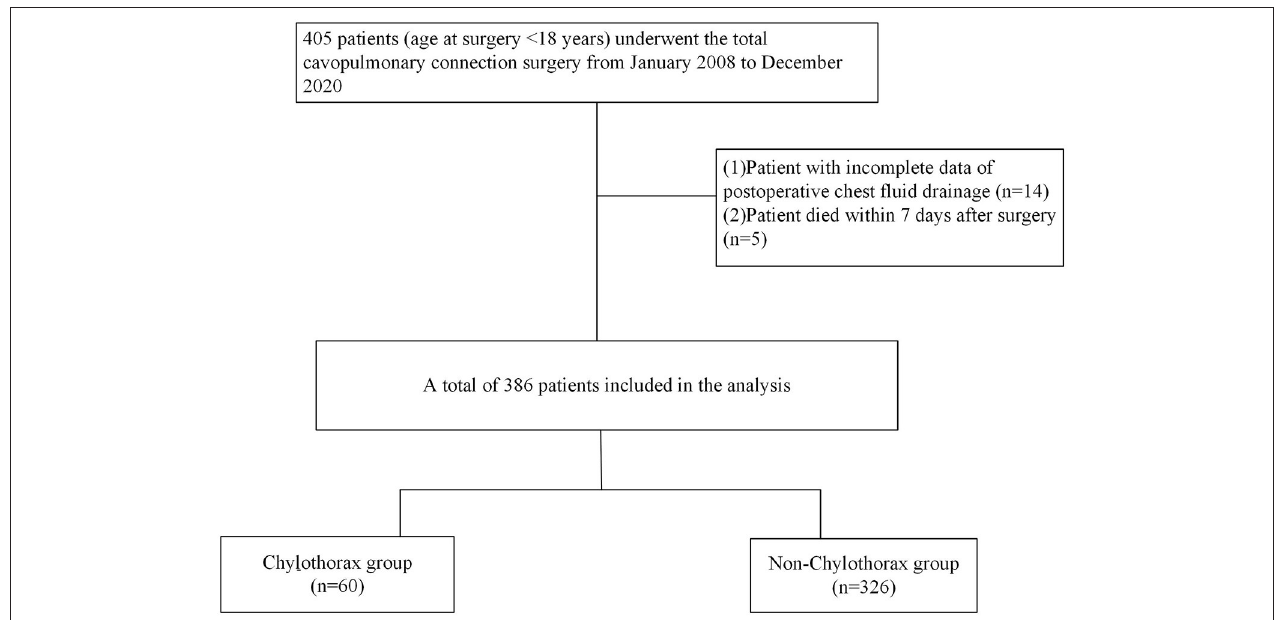
FIGURE 1 | Flowchart of